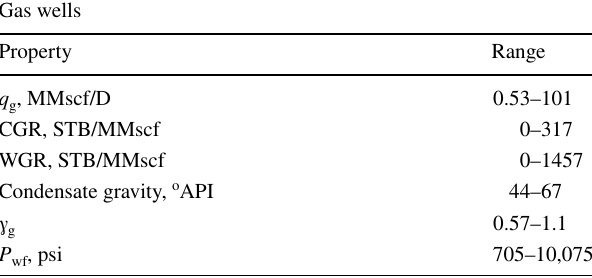
Table 2 Range of gas well data used in this study